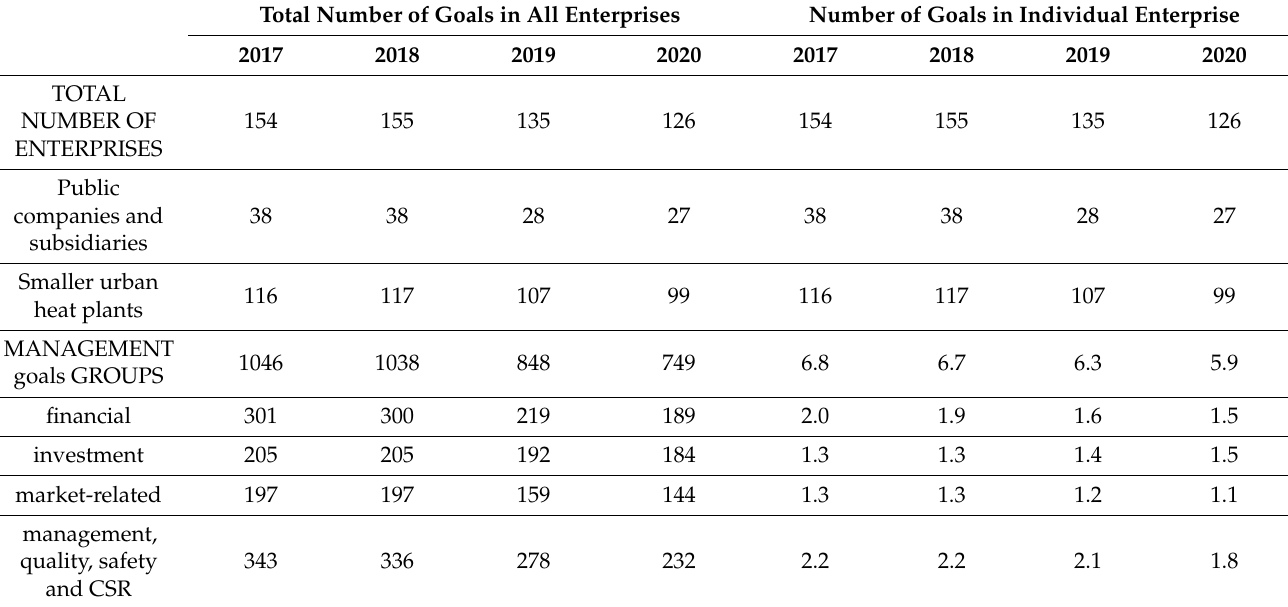
Table 2. Summary of management goals in selected groups in energy companies (in 2016–2020 in Poland). Total Number of Goals in All